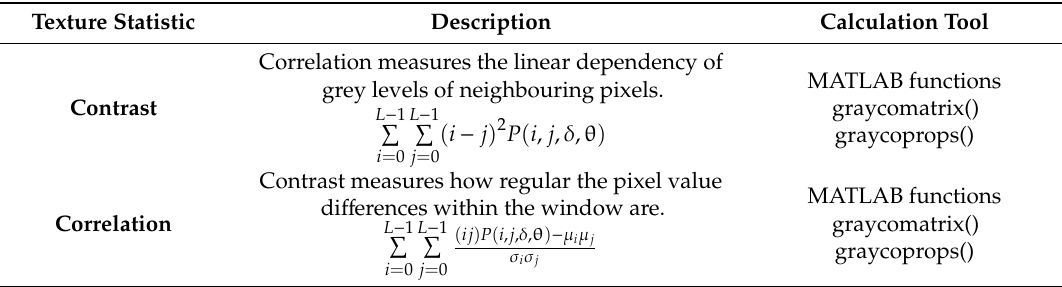
Table 4. Description of GLCM features used in the Textural Analysis, with i, j: row and column number, δ : inter-pixel distance, θ : orientation angle, µ , σ : mean and standard deviation of the row / column values, L: window size.